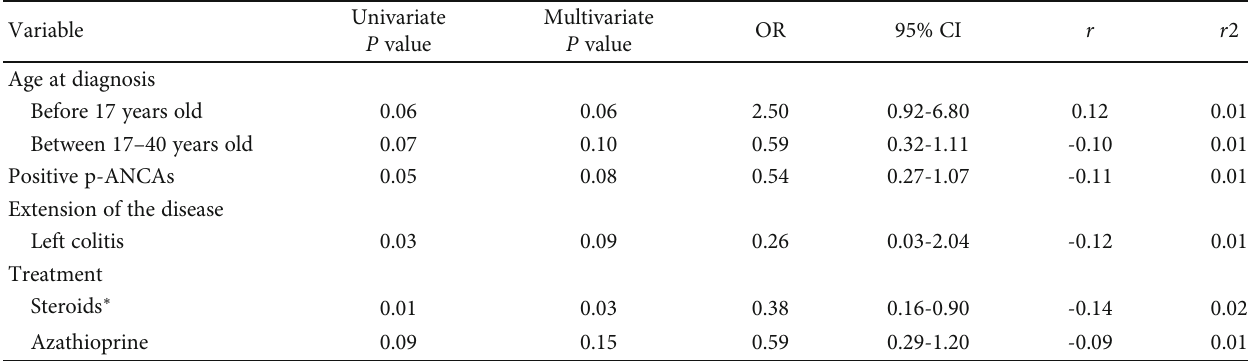
Table 2: Univariate and multivariate analysis for clinical characteristics at diagnosis associated with histologic remission during follow-up in patients with ulcerative